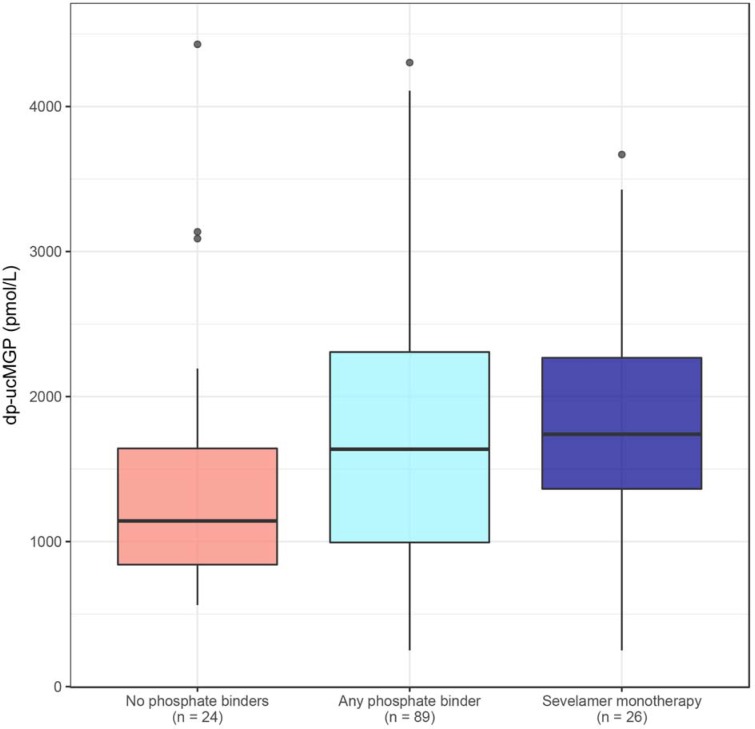
Dp-ucMGP levels stratified by phosphate binder use in patients on dialysis, as boxplots.Patients using no phosphate binders (n = 24): pink boxplot, patients using any phosphate binder (n = 89): light blue boxplot, and a subgroup of patients using sevelamer monotherapy (n = 26): dark blue boxplot. Median values of dp-ucMGP: 1142; 1637; and 1740 pmol/L, respectively.